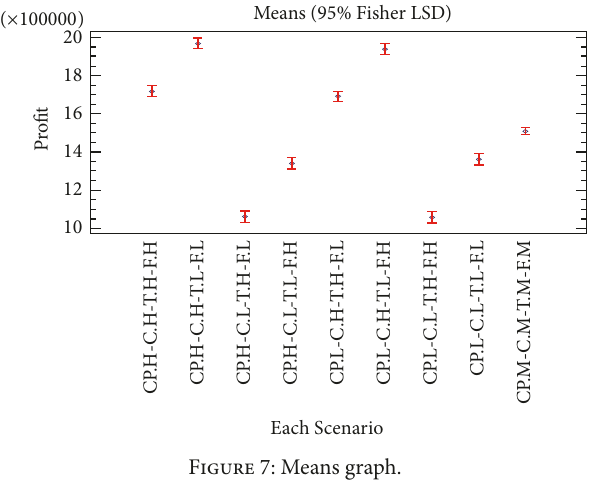
Figure 7: Means graph.